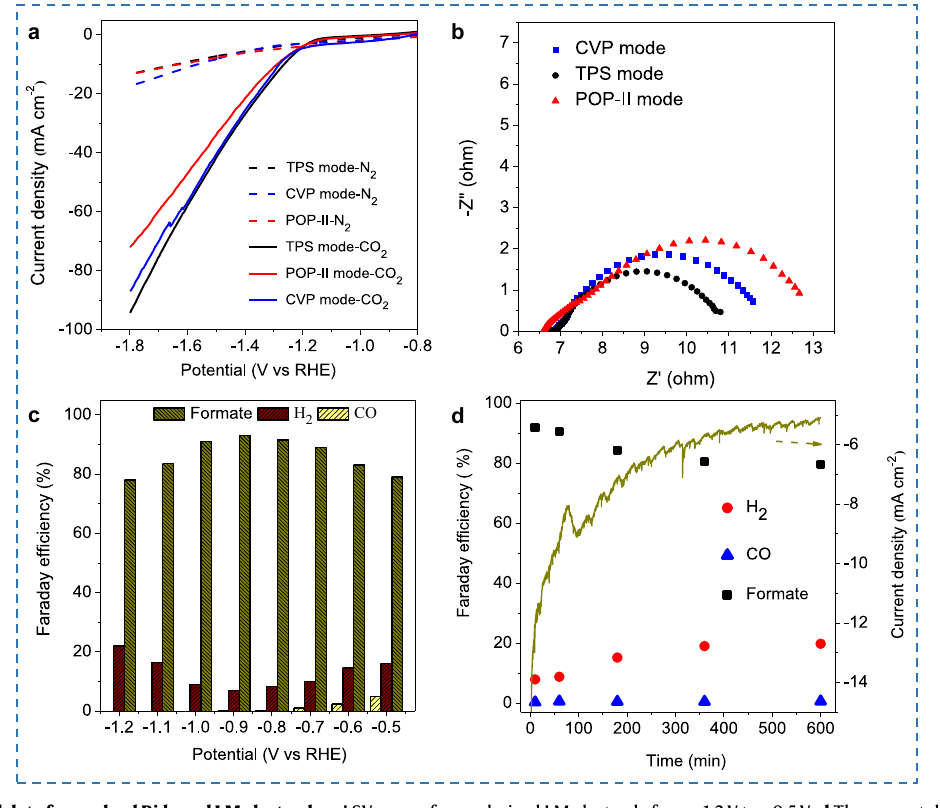
derived LMelectrode from − 1.2Vto − 0.5V. d The current density andFEofCO 2 RR during 10h of electrolysis with the TPS evolved LM electrode. Source data are provided as a Source Data fi